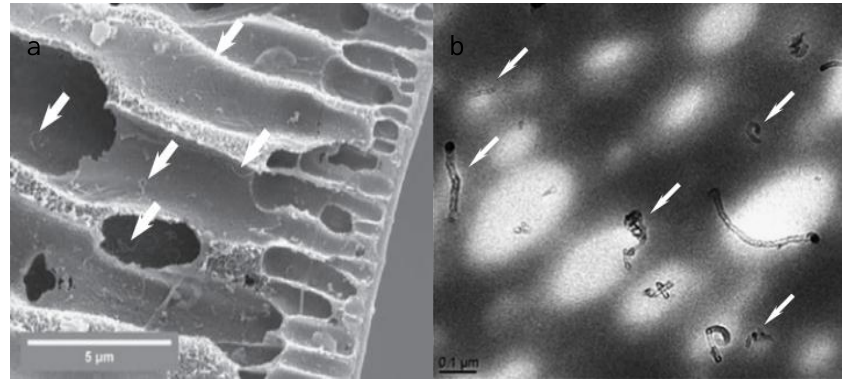
Figure 8. ( a ) SEM image and ( b ) TEM image of CNTs-PES membranes [70].